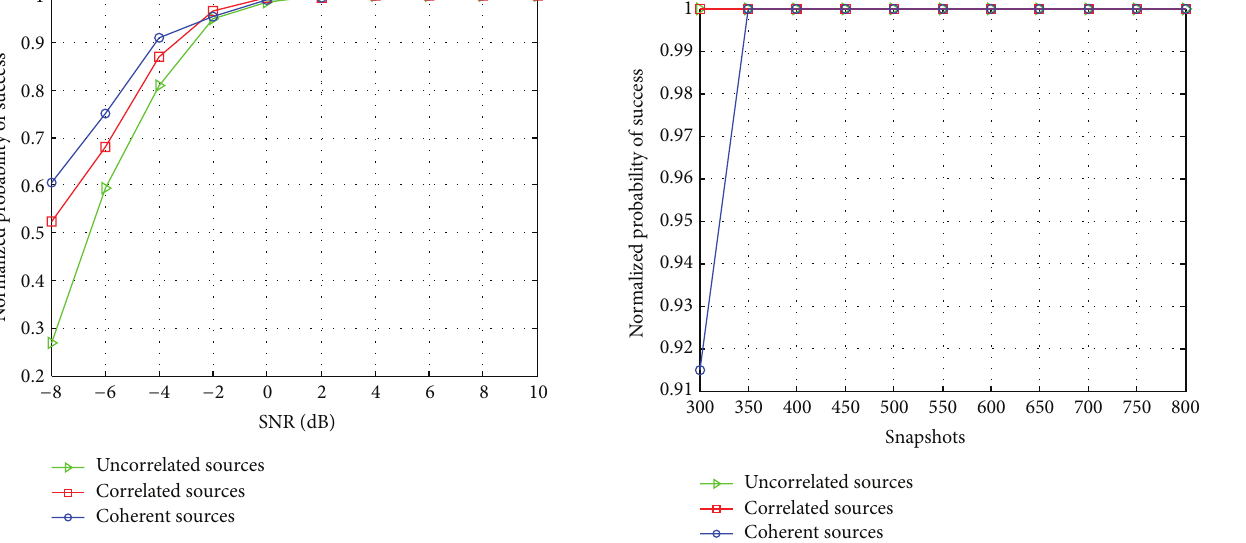
Figure 9: NPS of the proposed method versus input snapshots for the uncorrelated, correlated, and coherent